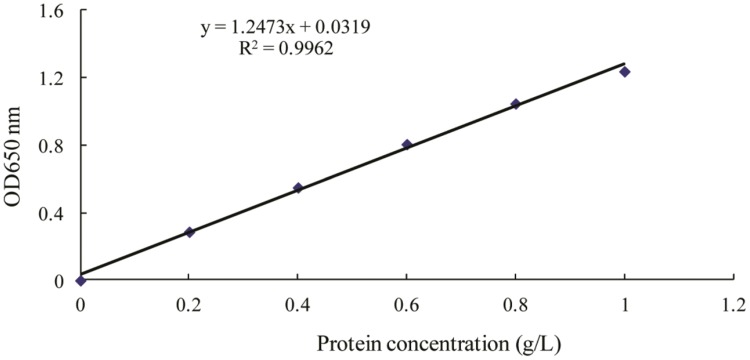
Standard curve for determination of protein by Lowry’s method (Lowry et al., 1951). OD650 for optical density at 650 nm wavelength.